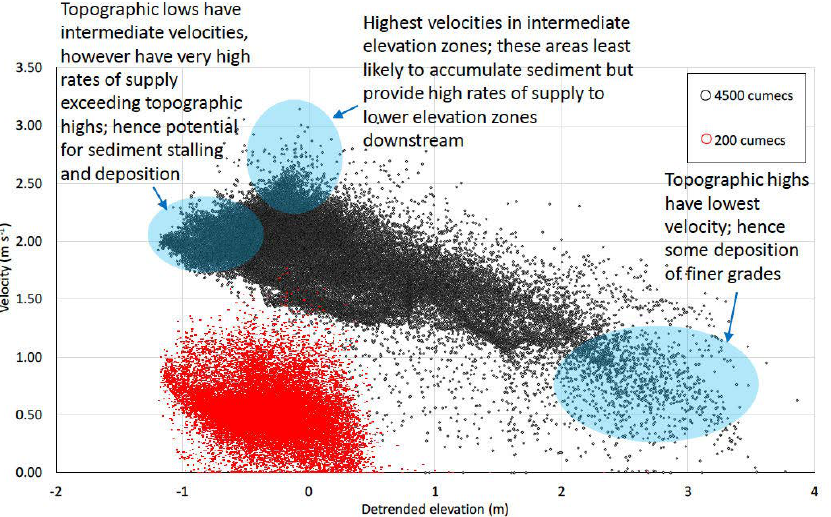
Figure 4. Velocity data taken from the same 5m pixels as the sediment thickness data (Fig. 3): for low discharge (red: 200m 3 s − 1 ), and high discharge (black: 4500m 3 s − 1